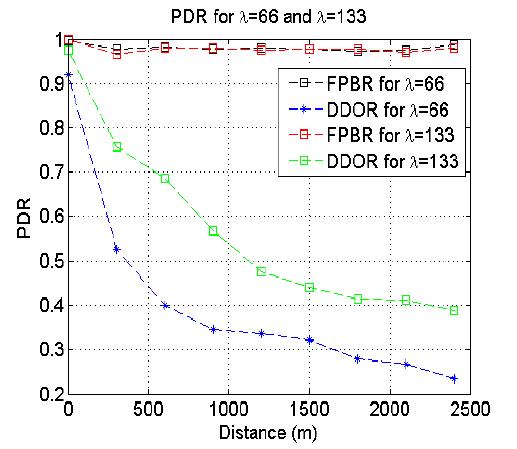
Figure 11. Packet Delivery Ratio (PDR) obtained with FPBR and DDOR when increasing the source-destination distance. The maximum vehicle acceleration was set to α = 4. Two different vehicle densities, λ = 66 and λ = 133, were considered for these